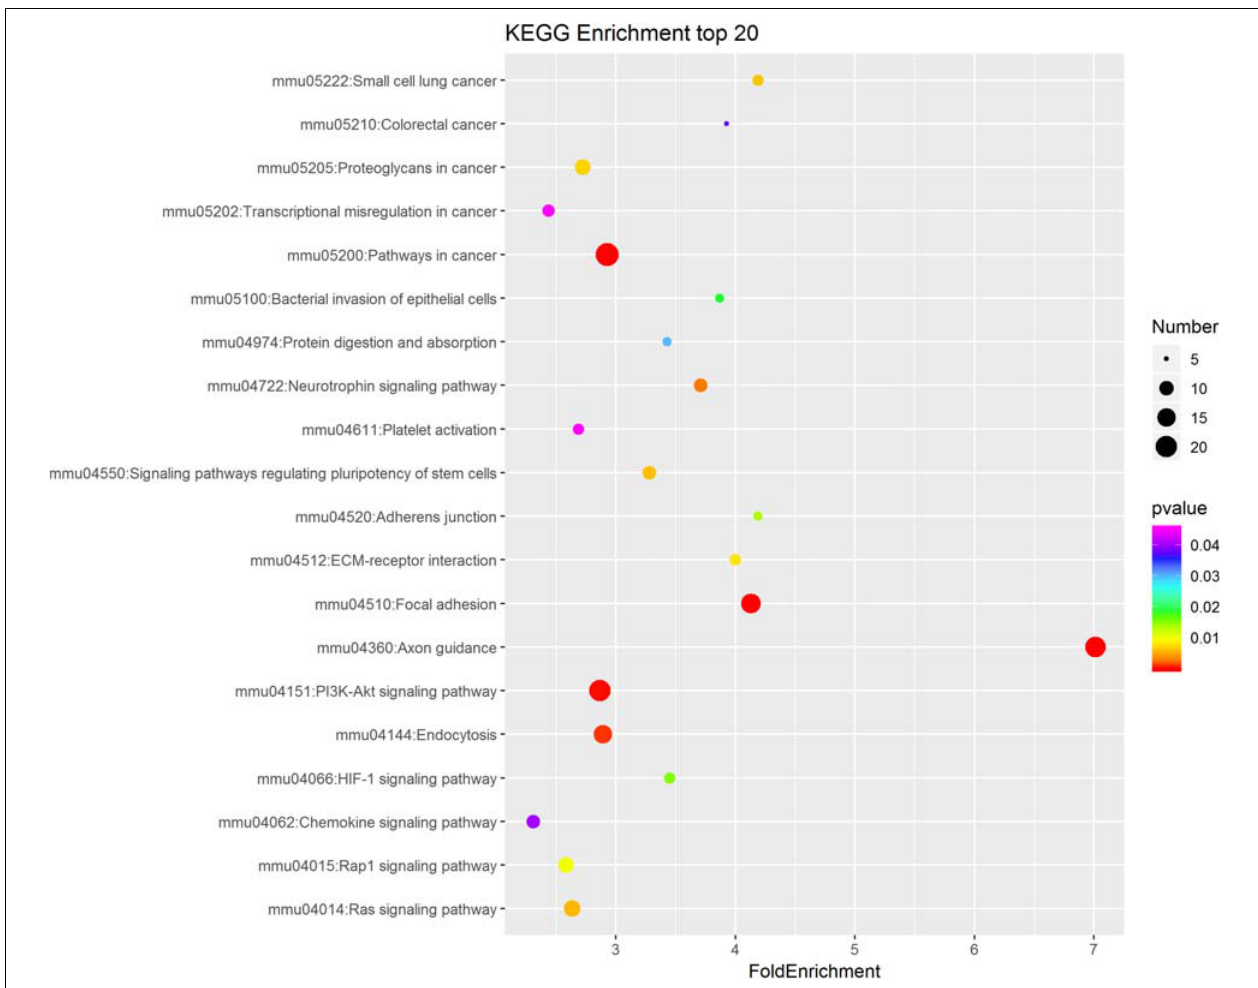
FIGURE 6 | KEGG pathway analysis of the intersectional putative target genes of common miRNAs in the three virus-infected groups. The top 20 significantly enriched KEGG pathways were shown in the bubble diagram. The difference in bubble size means that the number of target genes enriched in the pathway is different and, the larger the bubble, the more target genes are enriched. The bubble color represents the P value, and the color change from red-green-blue-purple represents a small to large transition of the P value. The smaller the P value, the more significant the difference. The expression of putative target genes involved in this KEGG pathway is inversely related to the expression of their targeting